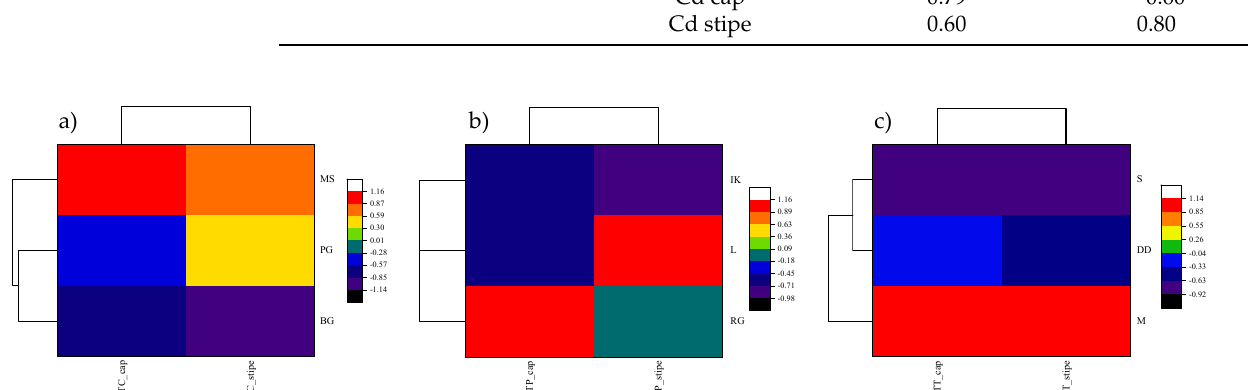
Figure 4. Clustered heatmap showing similarities between sampling locations and Cd contents in the cap and stipe of Tricholoma spp. (( a ) and TC: T. columbetta , ( b ) and TP: T. portentosum , ( c ) and TT: T. terreum ).